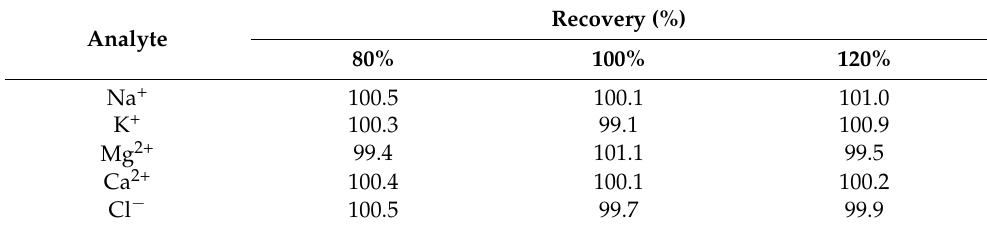
Table 7. Recovery of the IC